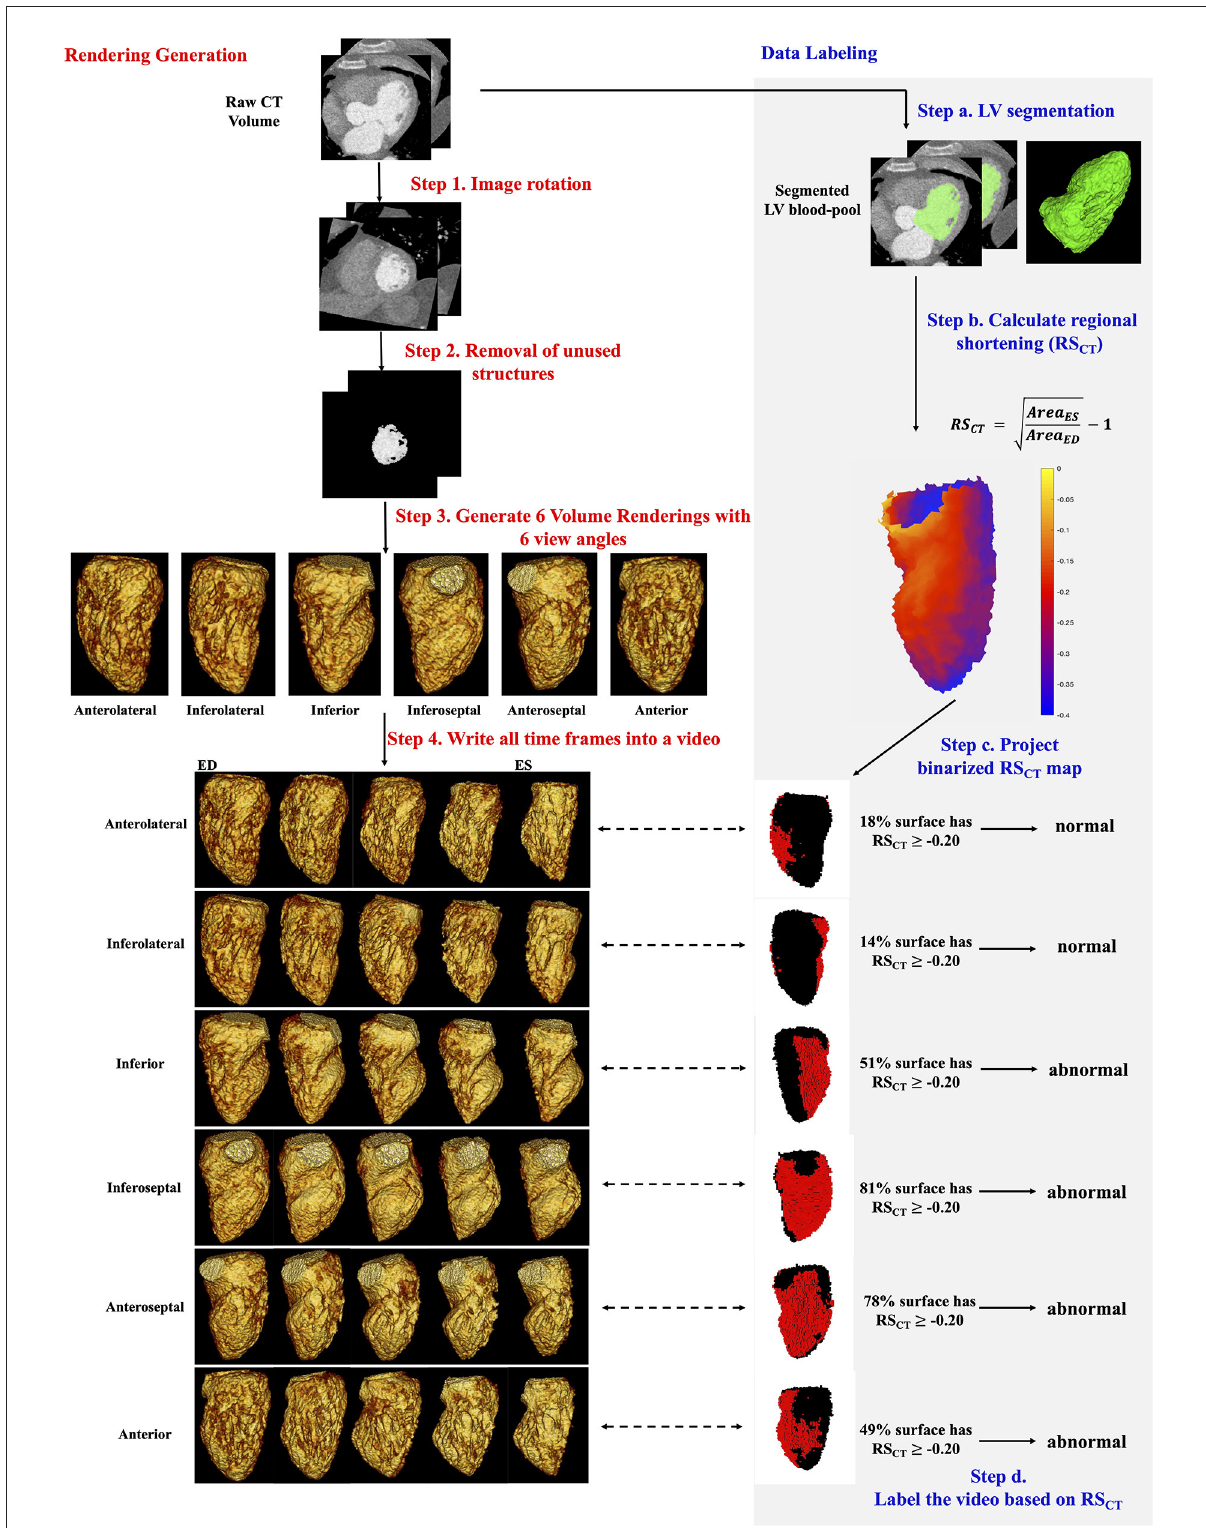
FIGURE1 Automatic generation and quantitative labeling of volume rendering video. This figure contains two parts: Rendering Generation: automatic generation of VR video (left column, white background, step 1-4 in red) and Data Labeling: quantitative labeling of the video (right column, lightgraybackground,stepa-dinblue).RenderingGeneration: Step1and2 :PreparethegreyscaleimageofLVblood-poolwithallotherstructures